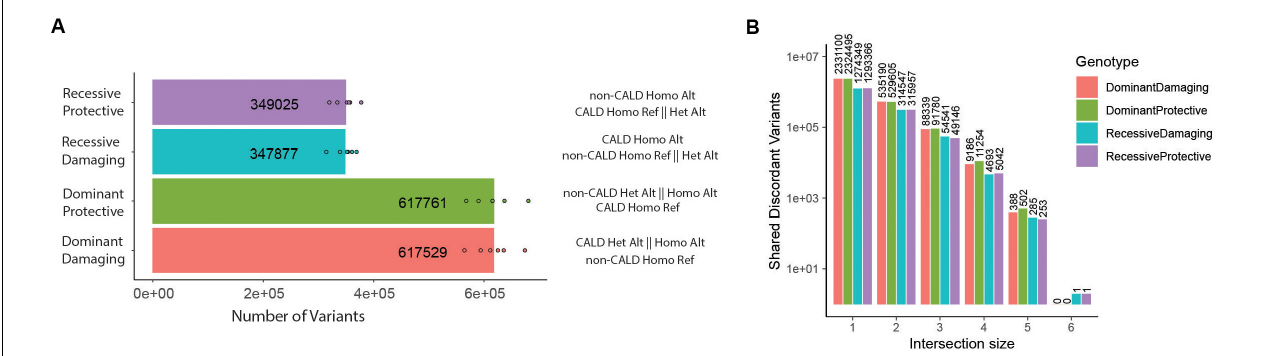
FIGURE 3 | Discordant genotype analysis. (A) Number of discordant genotypes in each category for each of the six families, with description of genotypes for non-CALD and CALD pairs per genotypic category (per-category means are displayed). (B) Upon intersection of discordant genotypes, the number of variants which exist within any intersection with set sizes of 1–6, meaning the set size of 6 is the intersection of all families, and a set of 1 are discordant variants only found in one family.